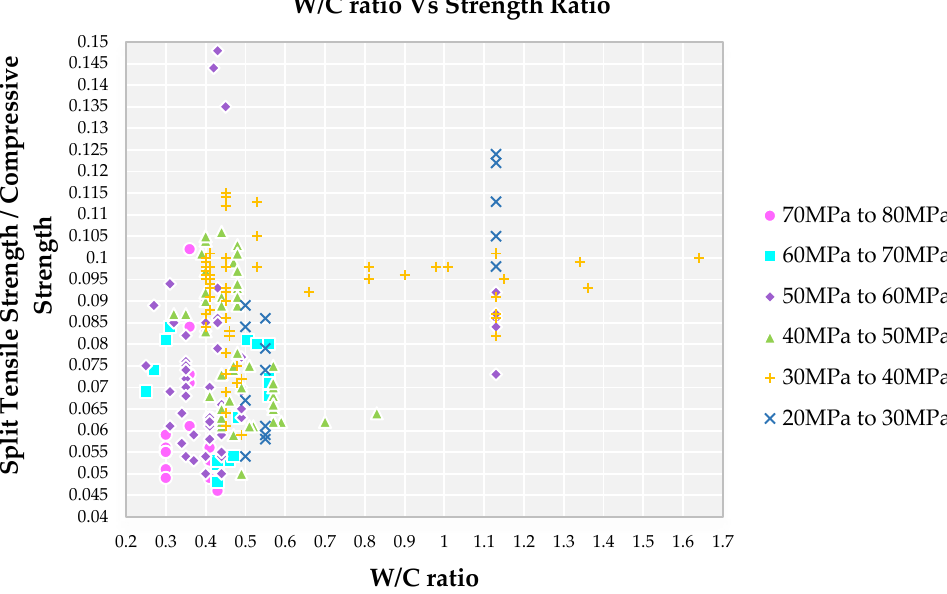
Figure 3. Impact of W/C ratio on split tensile strength to compressive strength ratio for different grades SCC concrete with recycled aggregate according to literature.